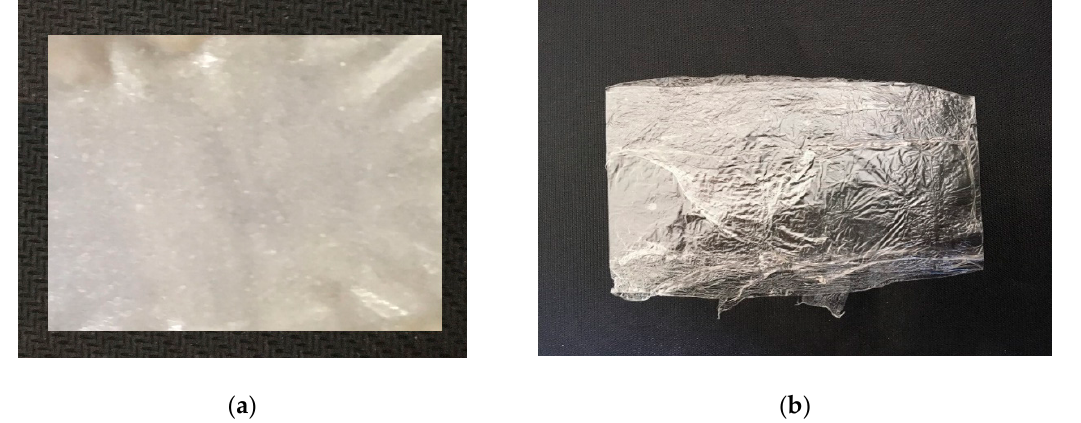
Figure 8. Photos of cellulose films obtained by coagulation of solution in IPA: aged in isopropanol and water ( a ); and dried ( b ).